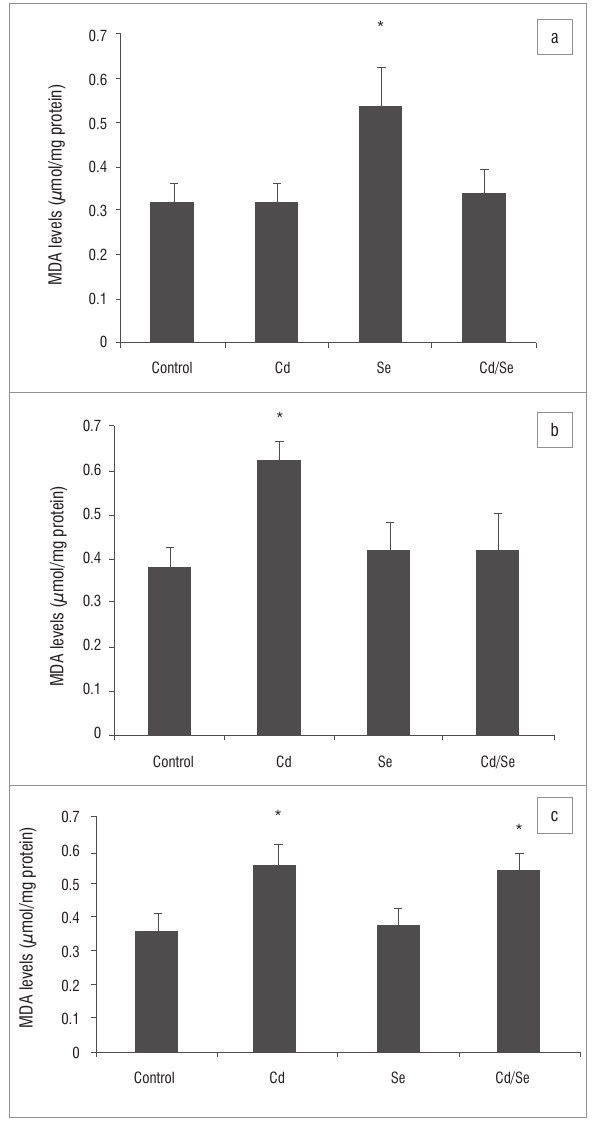
Figure 8: Mean±SD malondialdehyde (MDA) levels in the (a) livers, (b) kidneys and (c) testes of male rats ( n =5) that received cadmium (1.67 mg/kg cadmium chloride in saline), selenium (0.23 mg/kg sodium selenite solution), cadmium and selenium (Cd/Se; 1.67 mg/kg cadmium chloride in saline and 0.23 mg/ kg sodium selenite solution) or saline (control) daily (IP) for 15